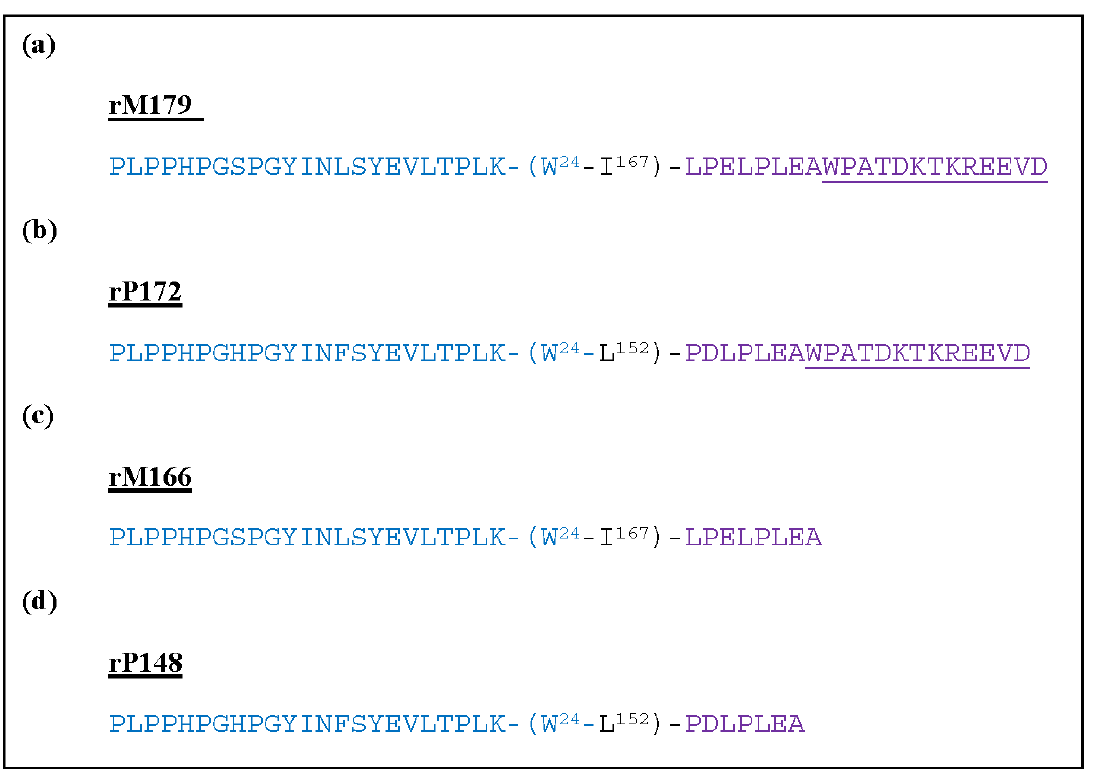
Figure 6. Comparison of N-terminal segment of mouse and porcine (blue) in the presence of the charged C-terminal motif (purple) with the C-terminal tail (purple and underlined) ( a ) is derived from mouse amelogenin containing the charged C-terminal tail and ( b ) porcine amelogenin containing the charged C-terminal tail. ( c , d ) retain the N-terminal region but without the charged portion of the C-terminal tail.